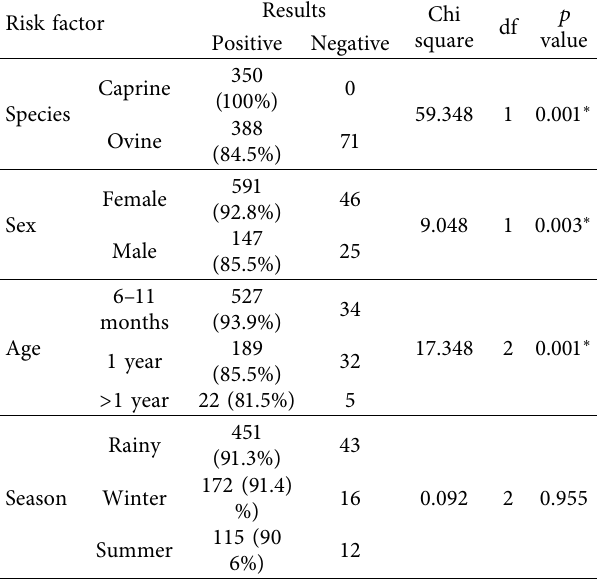
Table 3: Univariate and multivariate logistic regression analysis of selected risk factors associated with bluetongue virus in sheep and goats in Kassala